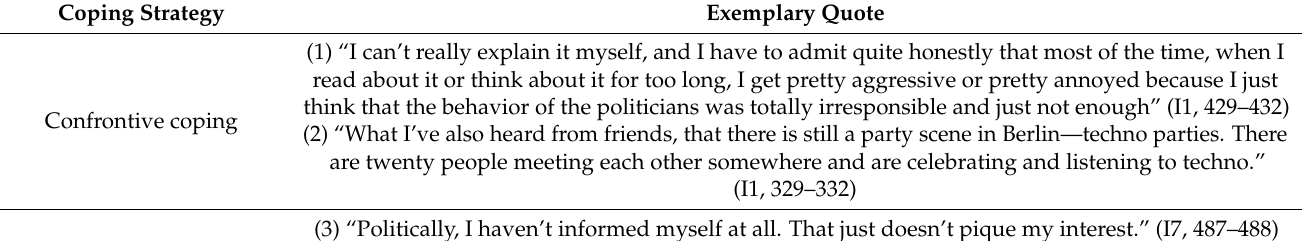
Table 5. Deductive coding: findings on the area of “coping